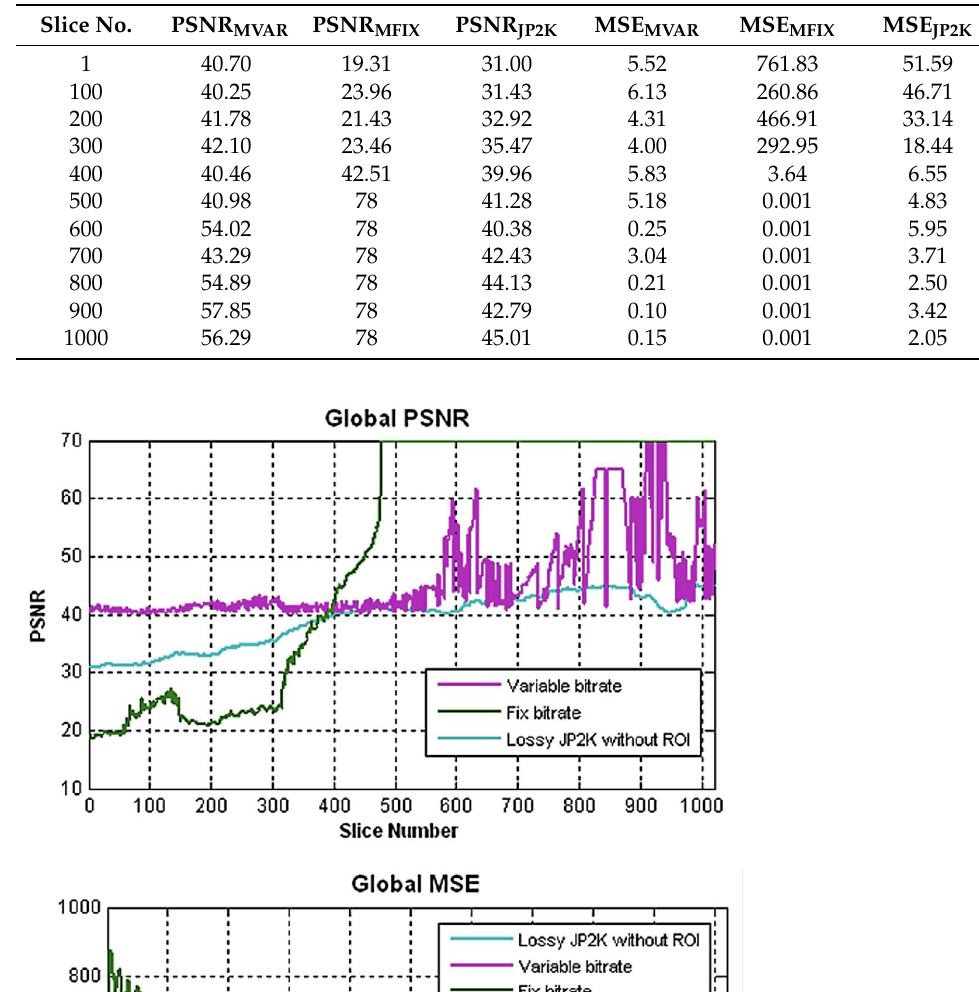
Table 2. Quantitative measurements in terms of PSNR (in dB) and MSE for different CTA slices: (MVAR) proposed method with variable bit rate; (MFIX) proposed method with fixed bit rate; and (JP2K) lossy Jpeg2000 without ROI.